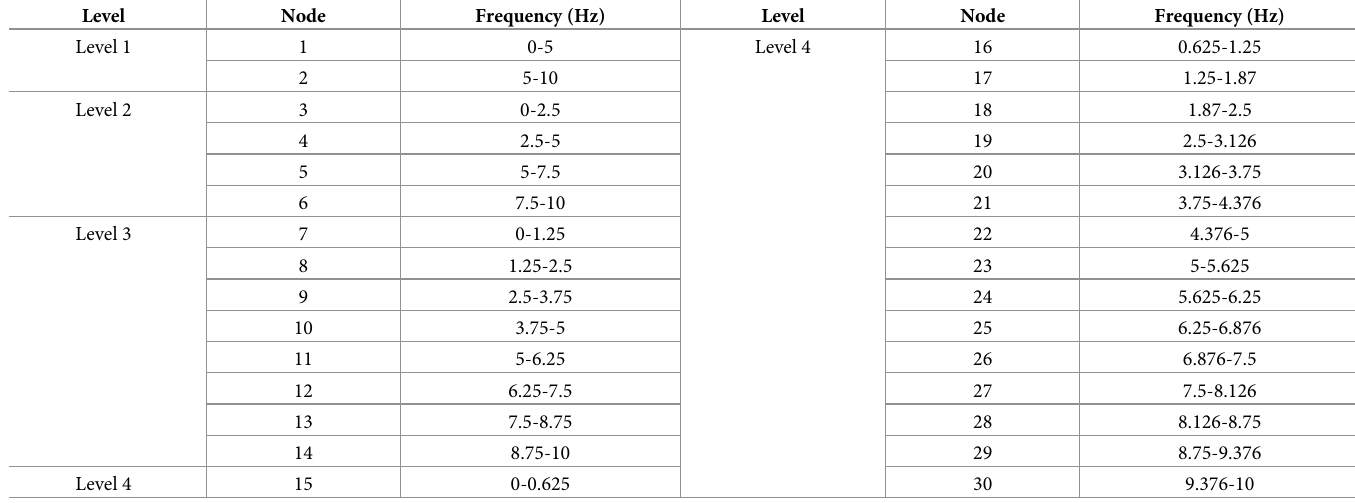
Table 2. Frequency mapping for MODWPT packets. Level indicates the level of decomposition and the frequencies are reported for a signal sampled at 20 Hz. Level Node Frequency (Hz) Level Node Frequency